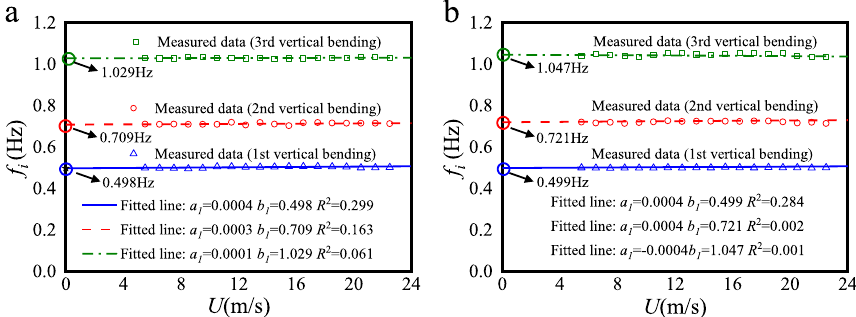
Fig. 14 Relationship between measured modal frequency and wind velocity in first three vertical bendings of PSRB: a SSI-COV; b